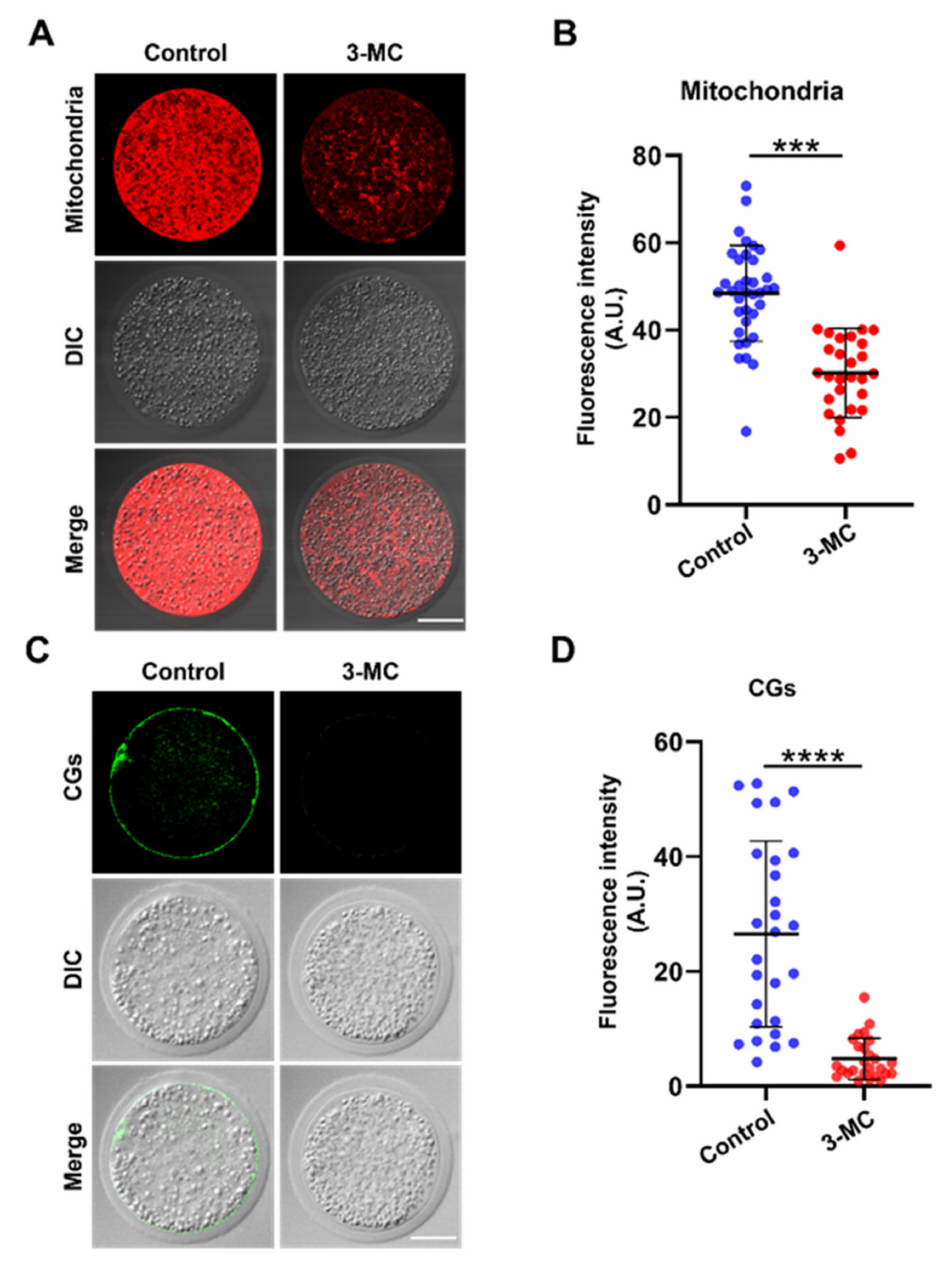
Figure 5. Effects of 3-MC exposure on the distribution of mitochondria and CGs in porcine oocytes. ( A ) Representative images of mitochondria staining in the control and 3-MC treatment groups, scale bar 25 µ M; ( B ) the fluorescence intensity of mitochondria signals was quantitatively analyzed in each group. Data were presented as mean ± S.E.M of at least three independent experiments. *** p < 0.001; ( C ) representative images of CG localization in the control and 3-MC treatment oocytes, scale bar 25 µ M; ( D ) the fluorescence intensity of CG signals was measured in each group. Data were presented as mean ± S.E.M of at least three independent experiments. **** p <